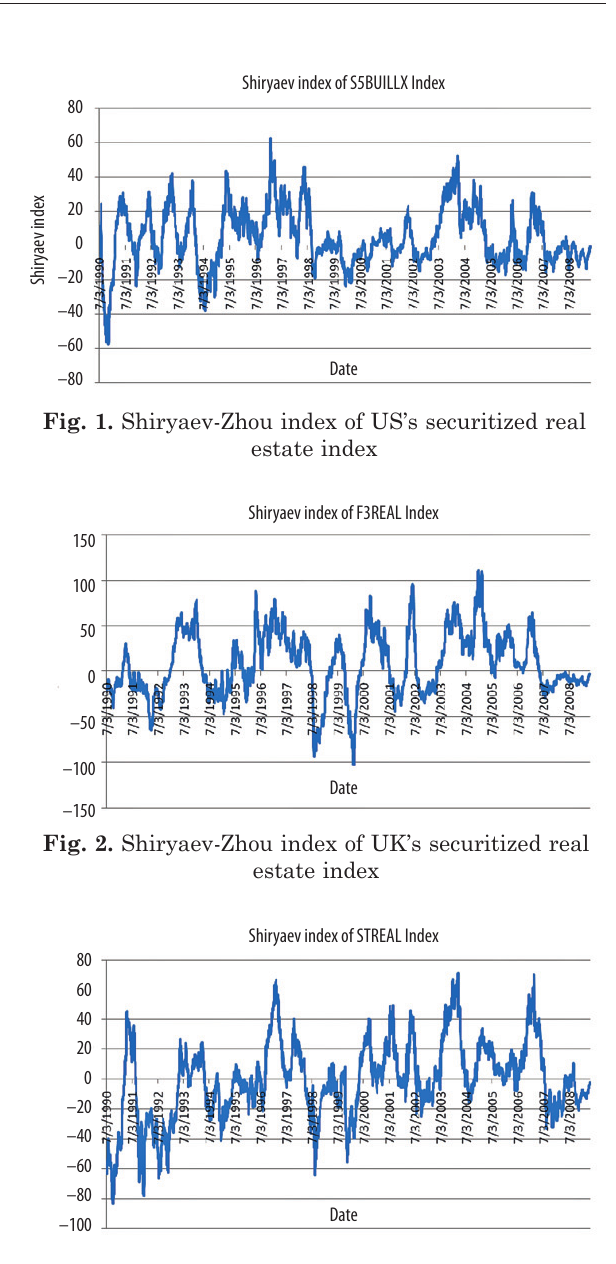
Fig. 3. Shiryaev-Zhou index of Canada’s securitized real estate index